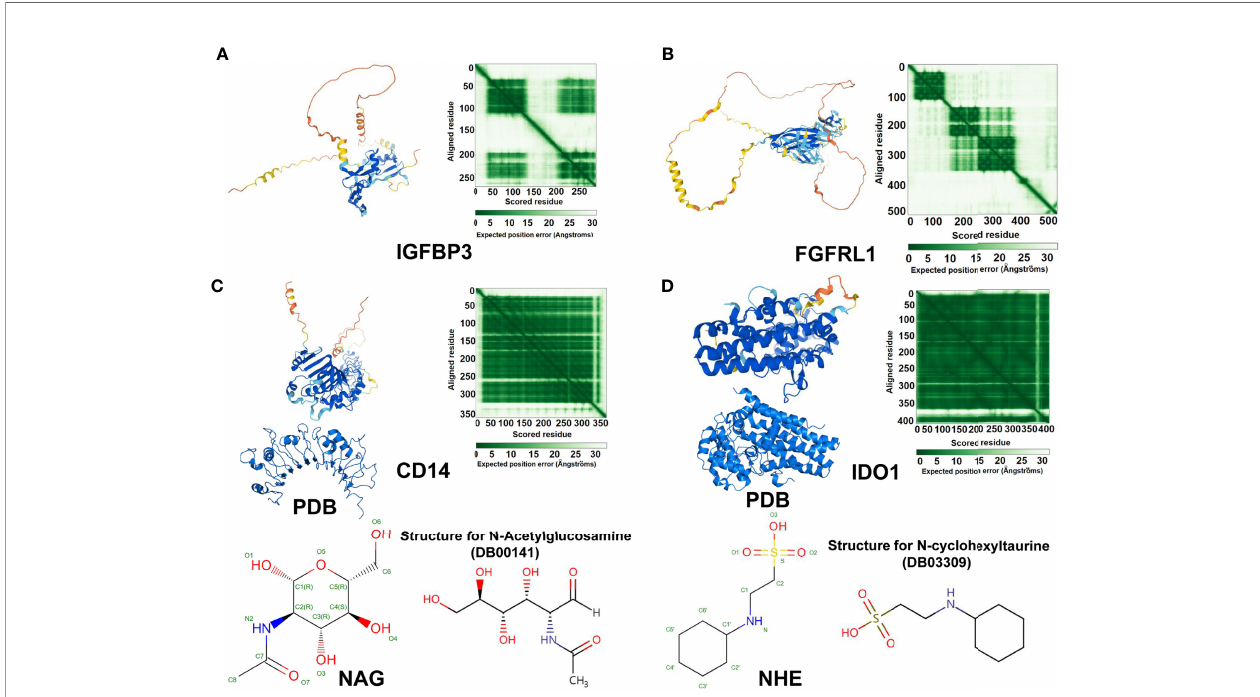
FIGURE 14 | Protein structure prediction comparison and drug targets of IGFBP3, FGFRL1, CD14, and IDO1. AlphaFold protein structure predictions of (A) IGFBP3, (B) FGFRL1, (C) CD14, and (D) IDO1. AlphaFold produces a per-residue con fi dence score (pLDDT) between 0 and 100. Some regions below 50 pLDDT may be unstructured in isolation. The shade of green indicates the expected distance error in Ångströms. The dark green module corresponds to the highlighted region. Dark green indicates good error, and light green indicates bad error. (C) Representative CD14 structure in the PDB database, which contains experimental structural data. In addition, the drug-target complex N-acetylglucosamine (NAG) bound to its directly interacting ligands. (D) PDB structure chain showing IDO1 and the drug-target complex: N-cyclohexyltaurine (NHE) bound to its directly interacting ligands. We thank all members of the laboratory for useful